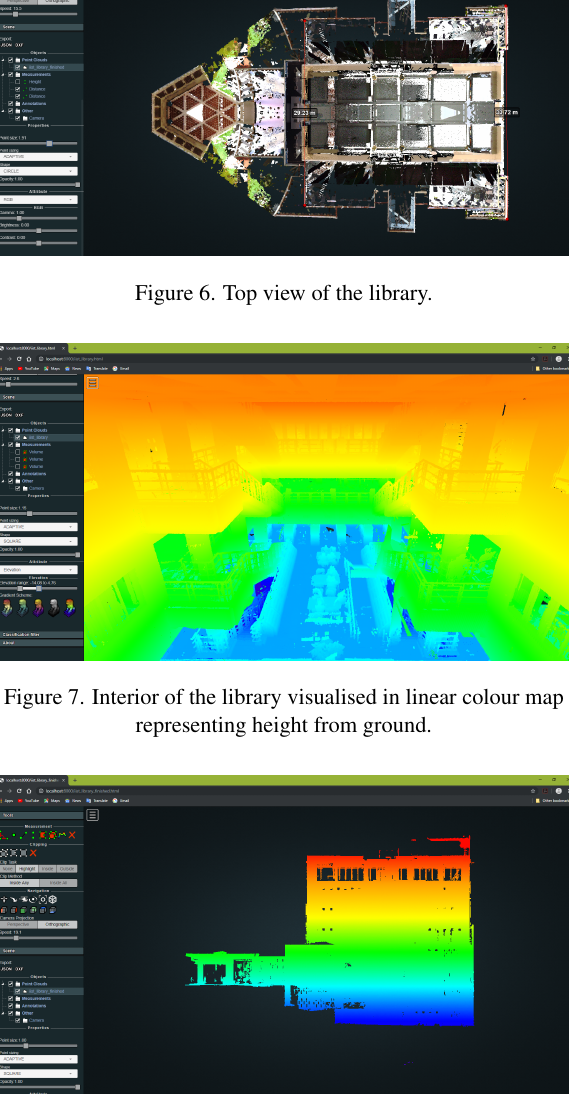
Figure 8. Exterior of the library visualised in linear colour map representing height from